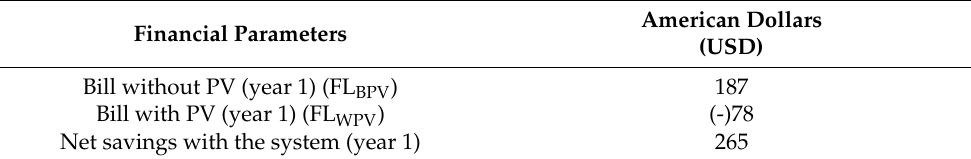
Table 6. Results of the SAM